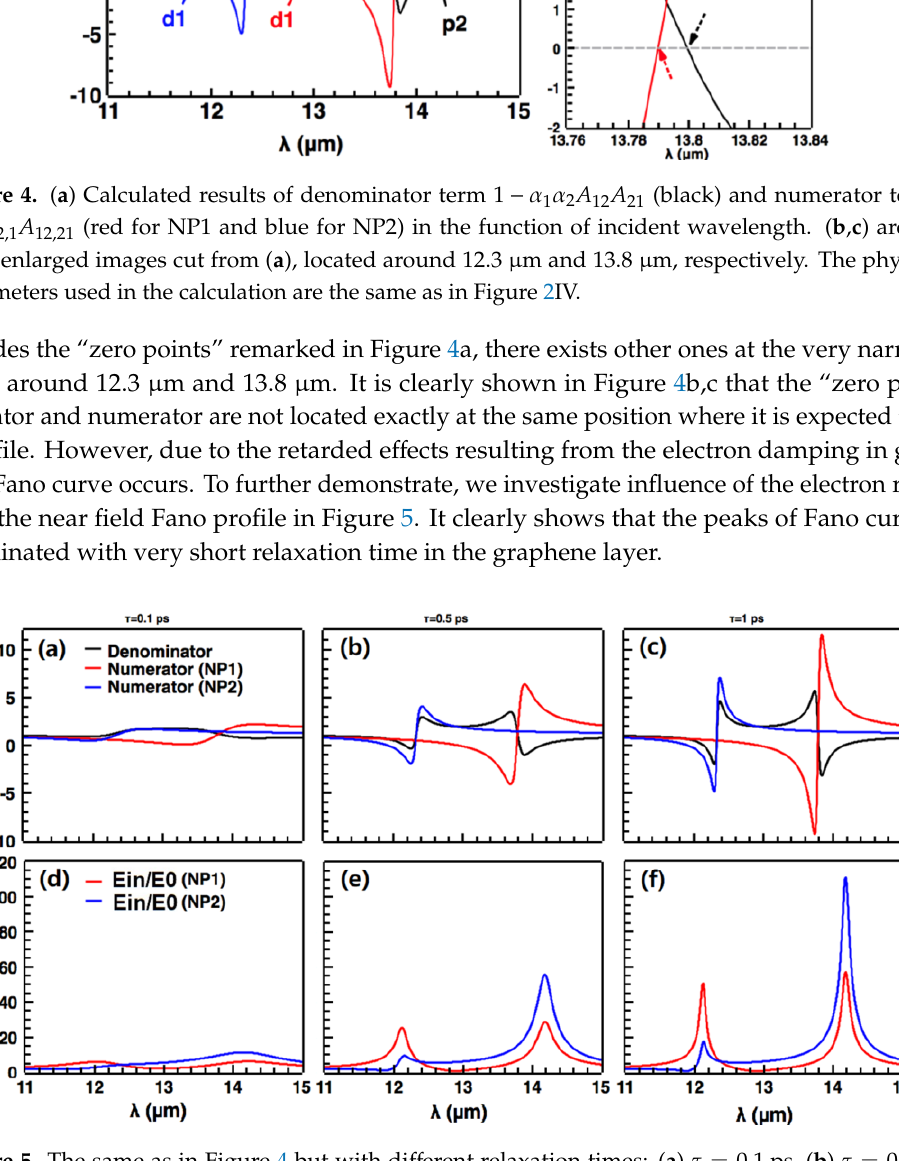
Figure 5. The same as in Figure 4 but with di ff erent relaxation times: ( a ) τ = 0.1 ps, ( b ) τ = 0.5 ps, ( c ) τ = 1 ps. Corresponding internal field enhancements are shown in ( d – f ),